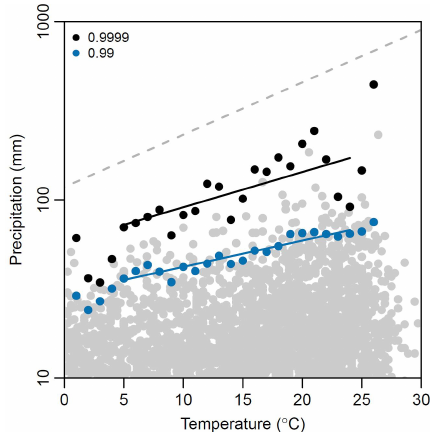
Figure 4. Q1–50 and Q3–50 temporal patterns projected for tem- perature rise of 5 ◦ C. Total rainfall of 160mm over 24h with each fraction representing accumulated rain for 4h periods.